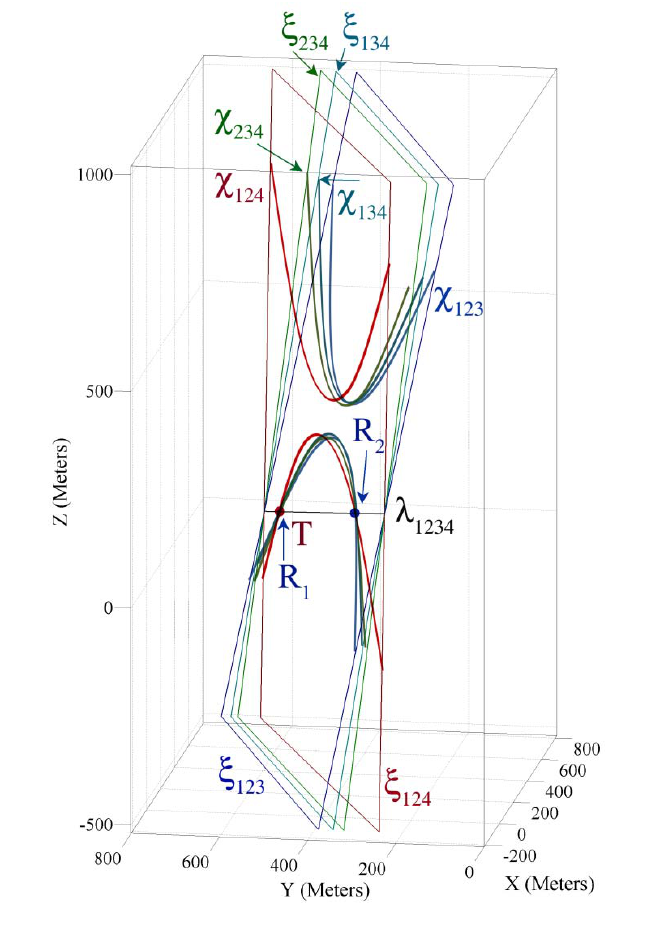
Figure 8. Pitfalls of the FCAL method in computing the accurate spatio-temporal information of a target object when both answers are related to past